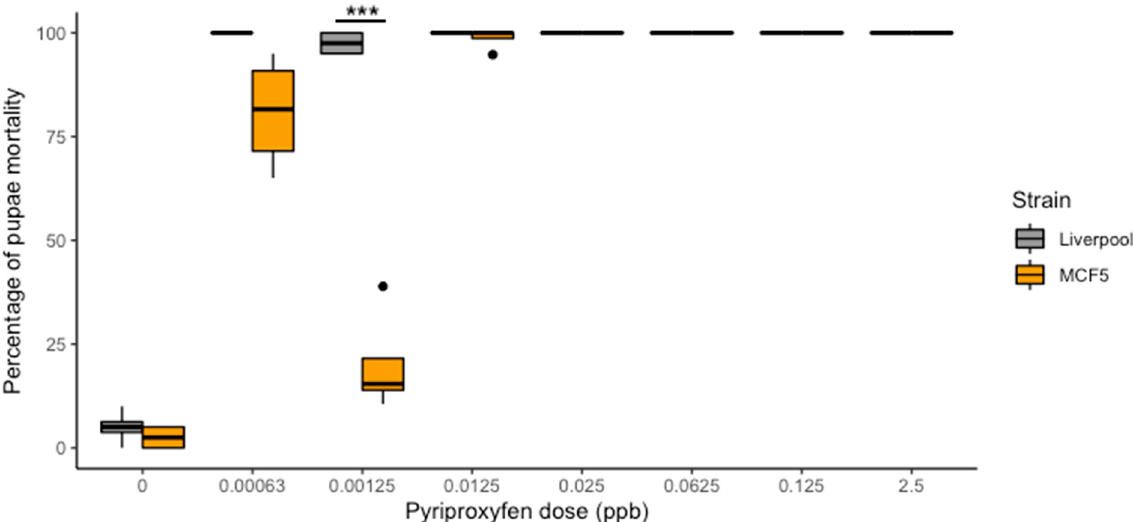
Figure 1. Mortalities induced by pyriproxyfen on the pupae of Ae. aegypti to the Liverpool susceptible strain and the field collected strain (MCF5) from South Texas. *** Shows statistical significance at p ≤ 0.001.